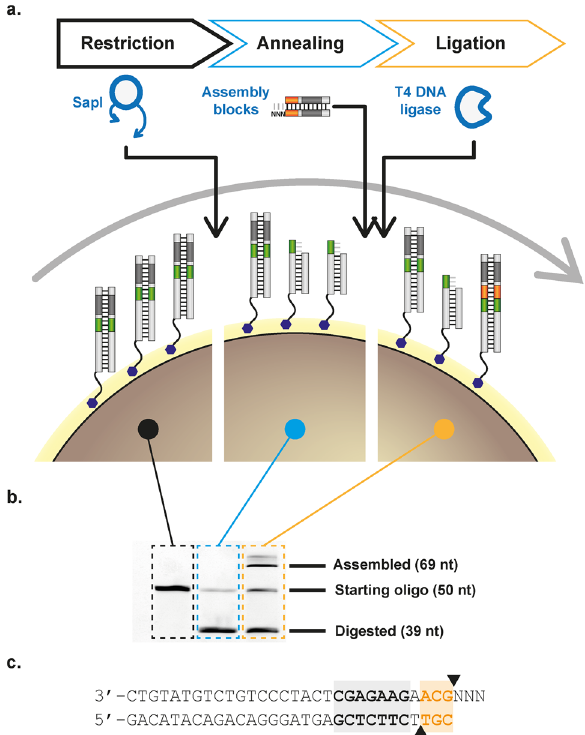
Figure 1. Producing length and compositional variation with InDel assembly. ( a ) At each assembly cycle, dsDNA templates bound to the paramagnetic beads are restricted with Sap I (a type IIs endonuclease), building blocks annealed and ligated. After ligation, the cycle can be restarted. Compositional variation is achieved primarily by combining pools of different building blocks. ( b ) Denaturing gel electrophoresis of fluorescently labelled template across the different steps of the cycle show that restriction digestion and ligation are not carried out to completion in any step, underpinning the length variation of the resulting libraries. ( c ) Sequence of a building block. A long double-stranded region is used to stabilize building block annealing and ensure efficient endonuclease activity. Sap I recognition site is shown in grey and restriction sites as black